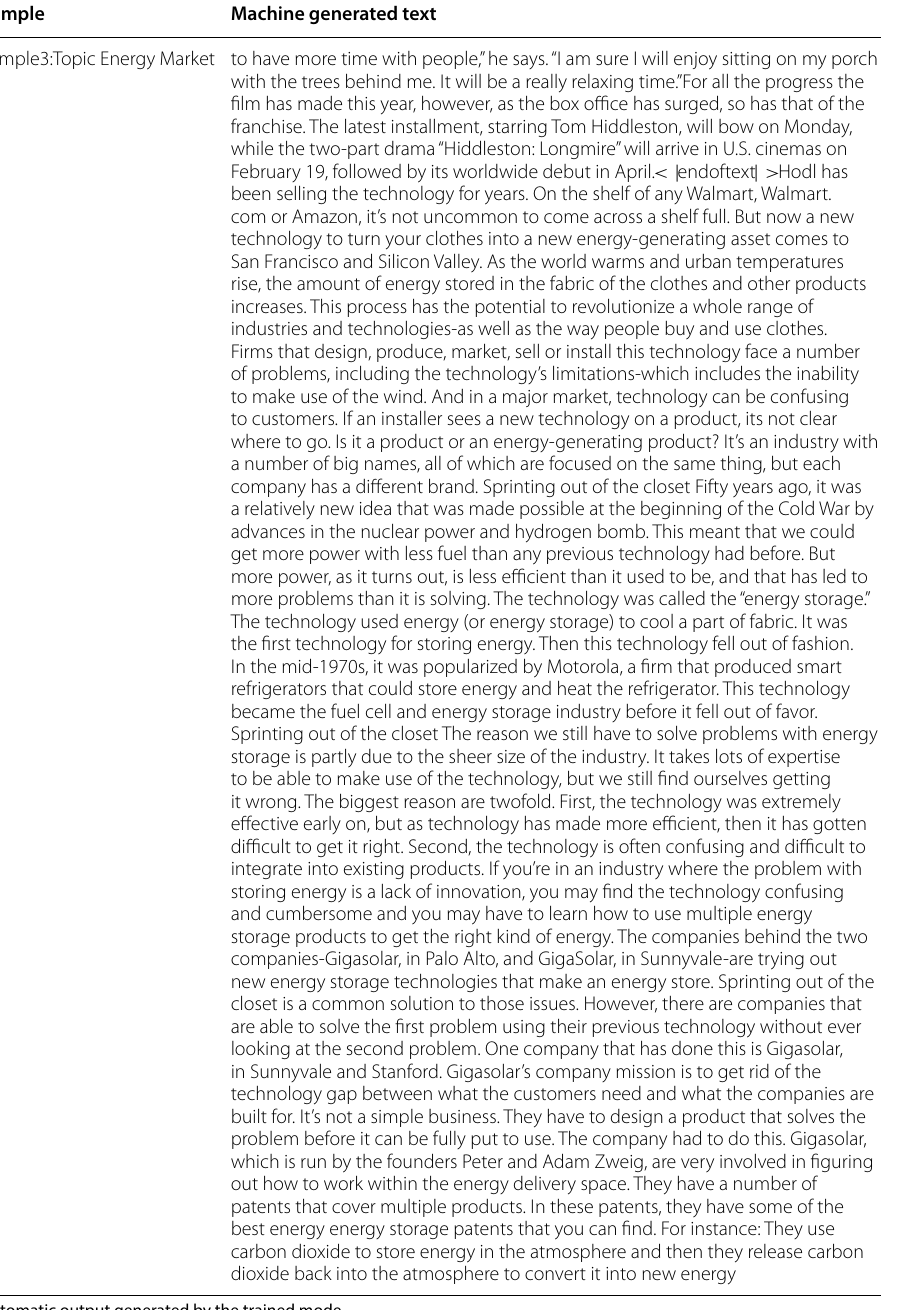
Automatic output generated by the trained mode